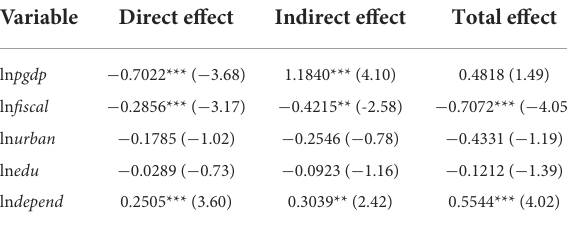
TABLE 8 Direct, indirect, and total effects of the spatial Durbin model.